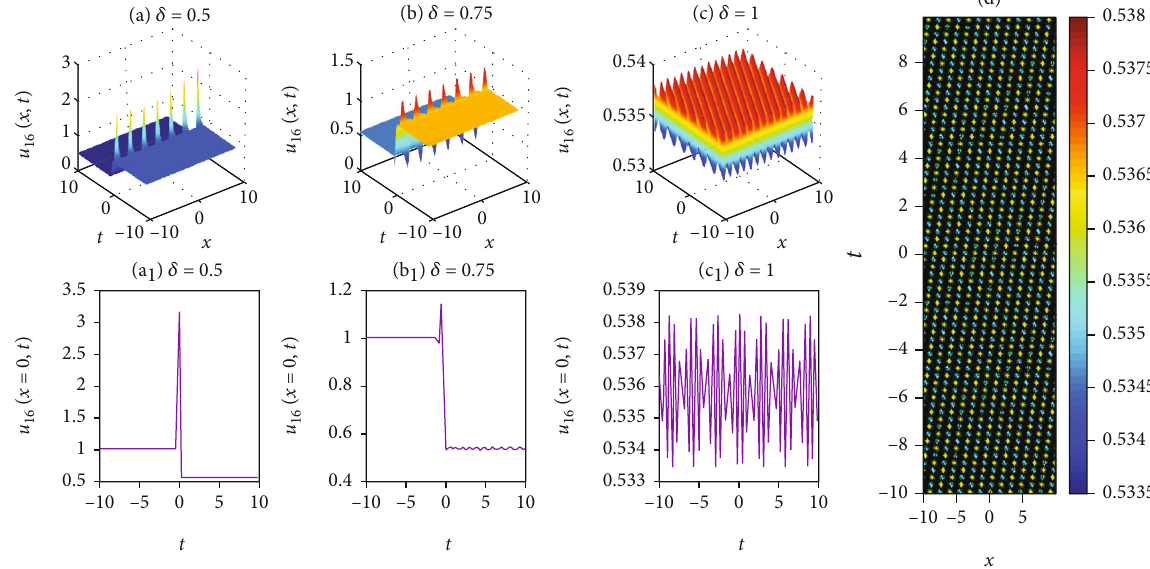
ð x , t Þ . (a – c) 3D plots. (a – c ) 2D plots. The right side vertical fi gure shows the density plot 14 1 1